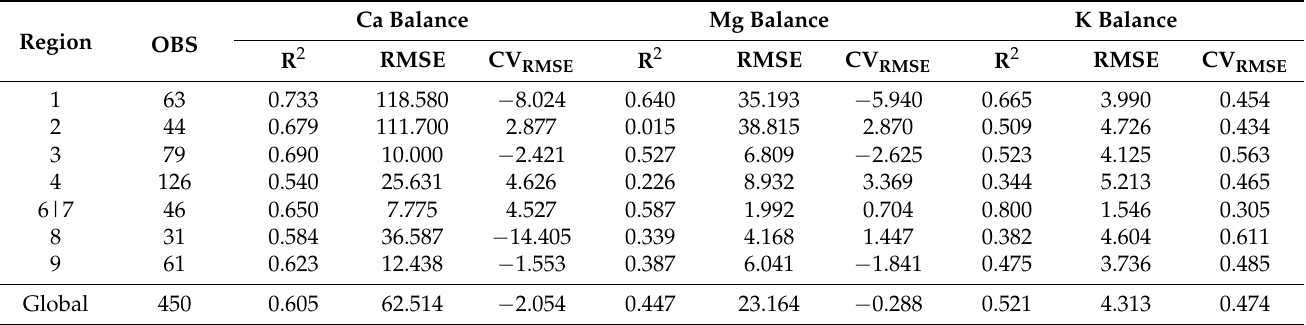
Table 1. Indicators of model performance for the soil-related balances (weathering + deposition— leaching with seepage) in the validation data set. OBS: number of observations; R 2 : coefficient